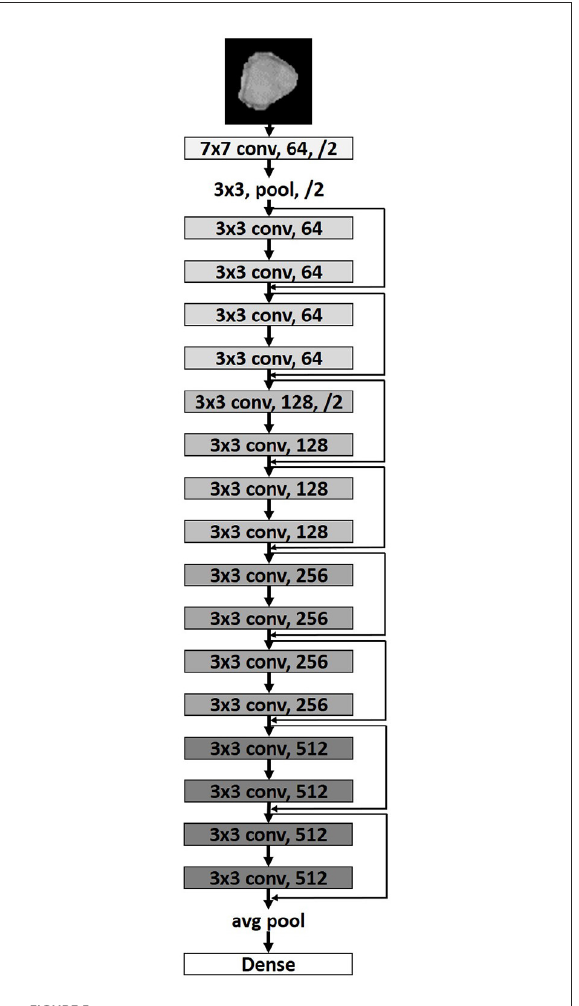
FIGURE5 Modified ResNet18 architecture (He et al., 2016). The first value corresponds to the core size of the convolution mask, the second value is the number of neurons in this layer, /2 indicates that the image size is reduced by half in both width and height.